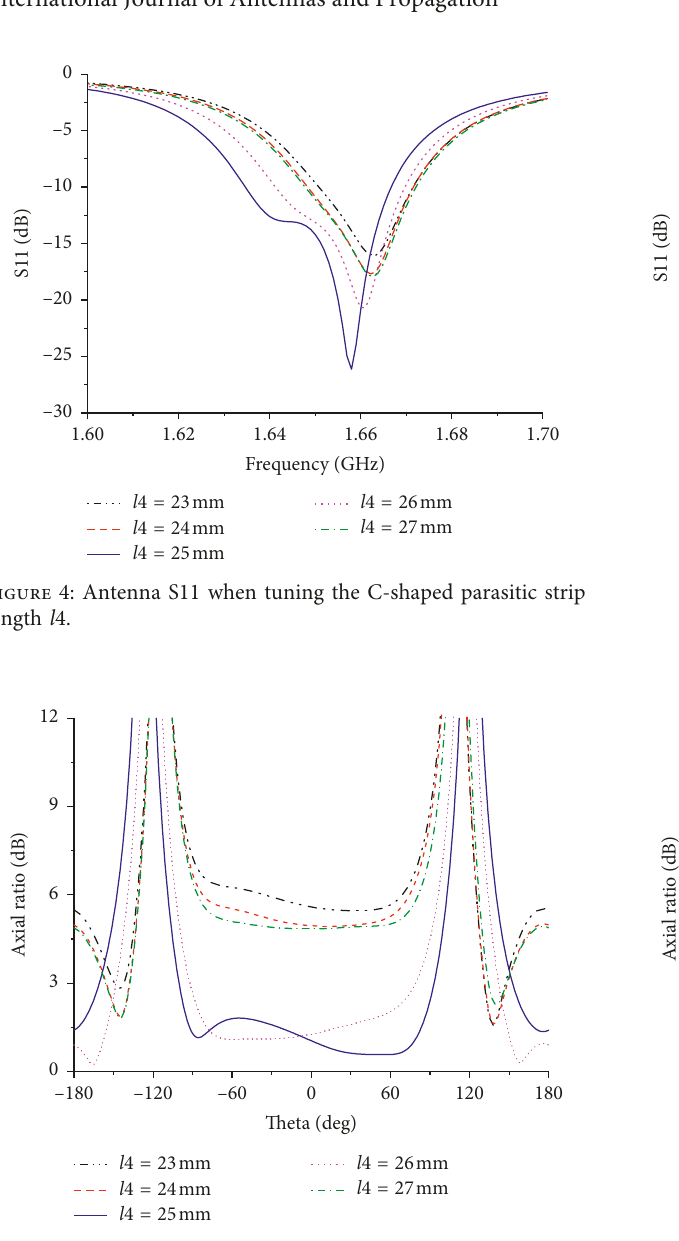
Figure 5: The AR against theta at phi � 0deg plane when tuning the C-shaped parasitic strip length l 4.